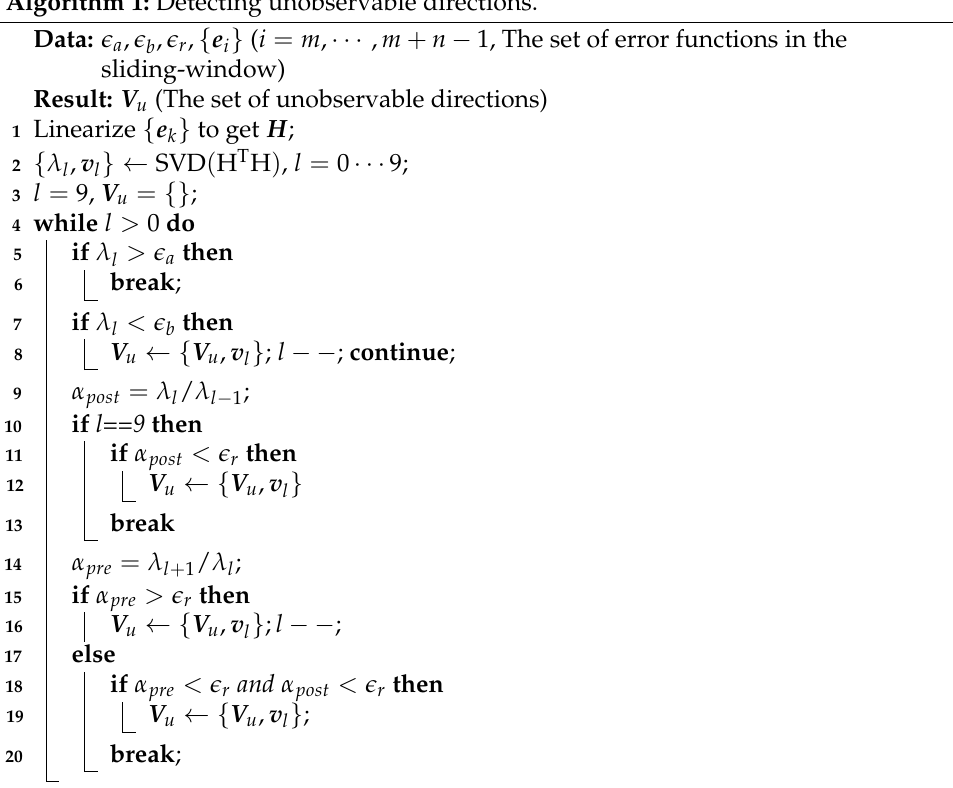
Algorithm 1: Detecting unobservable